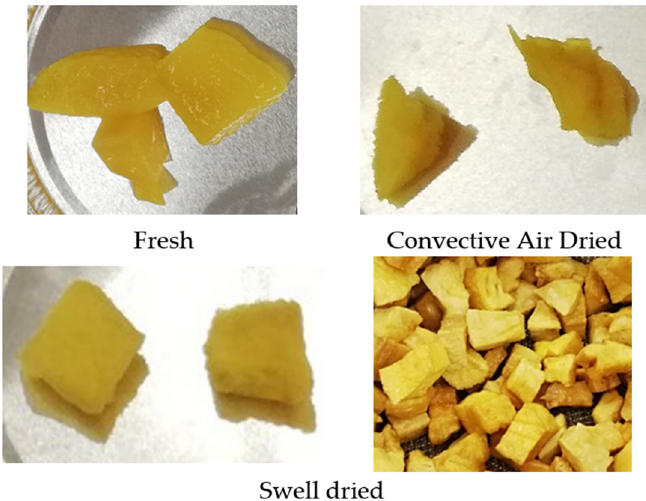
Figure 5. Photographs of Fresh, Convective Air-Dried, and Swell-Dried mangoes. Table 2. Experimental data of drying kinetics of mangoes. Evolution of moisture content in dry